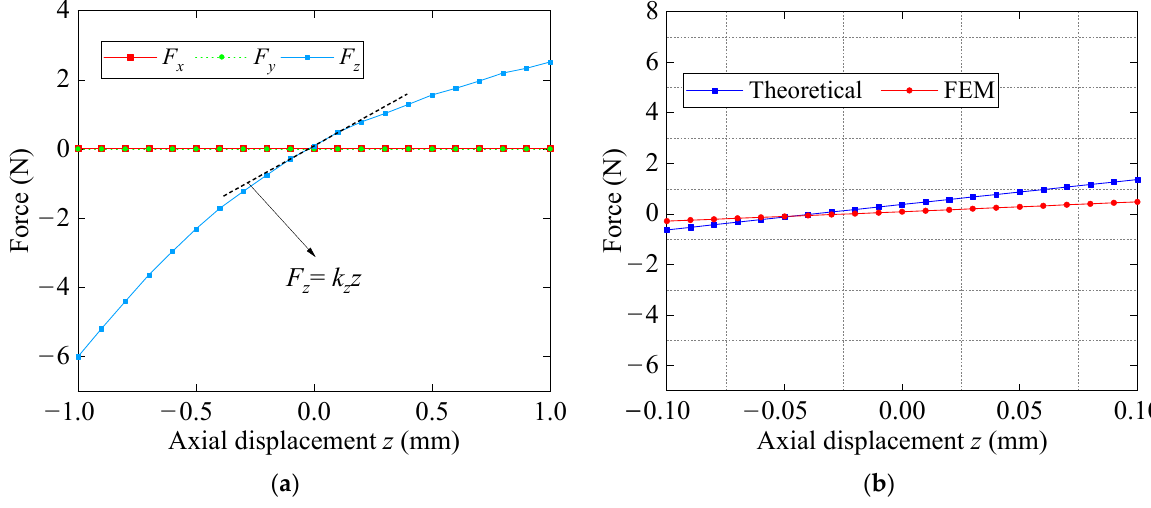
Figure 9. Relationship curve between the permanent magnetic force and the impeller displacement: ( a ) Variation law of the permanent magnetic force under axial displacement; ( b ) Variation curve of axial stiffness with axial displacement.